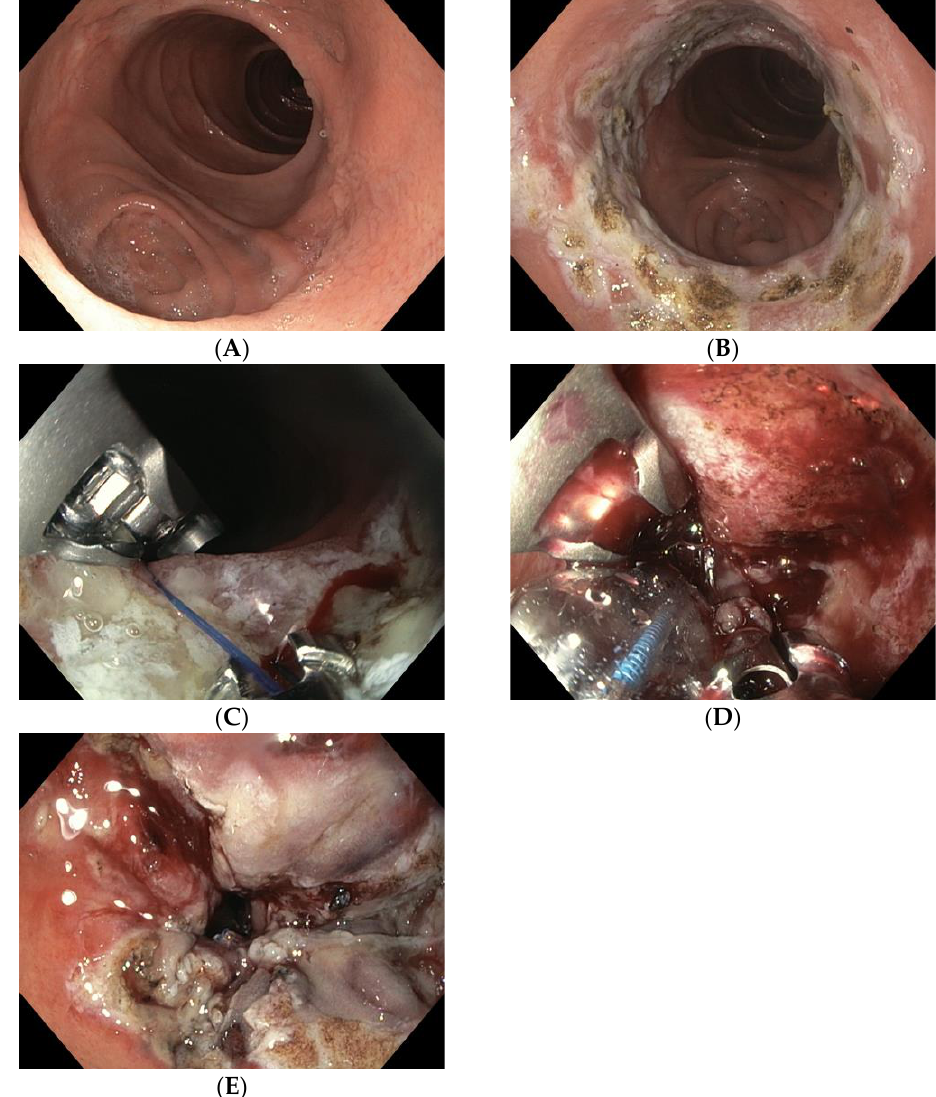
Figure 1. ( A ) Dilated GJA; ( B ) ablation of the gastric rim via APC; ( C ) suturing the anastomosis with the Apollo Overstitch system; ( D ) suture size control using an 8 mm CRE balloon; ( E ) narrowed GJA after TORe.